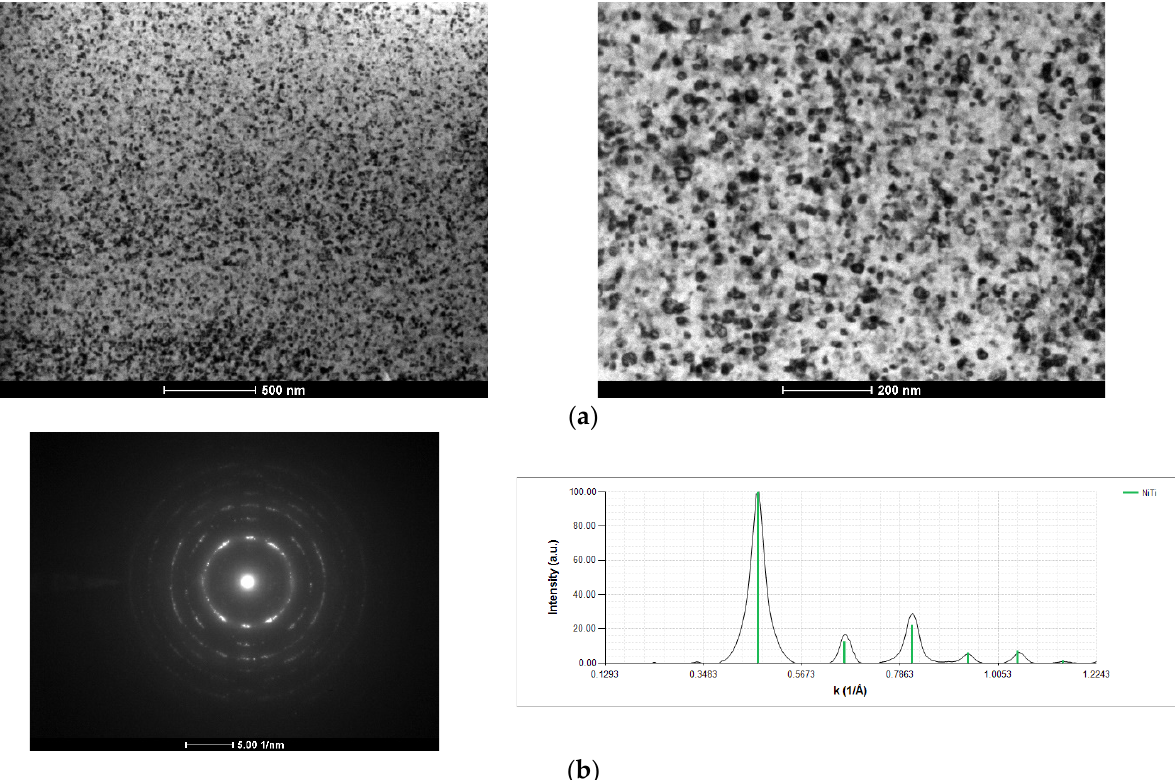
Figure 10. ( a ) BF TEM cross-section micrographs, and ( b ) SAED pattern and respective indexation of a Ni/Ti thin film following ignition by mode I ( φ = 0.20 mm W wire).